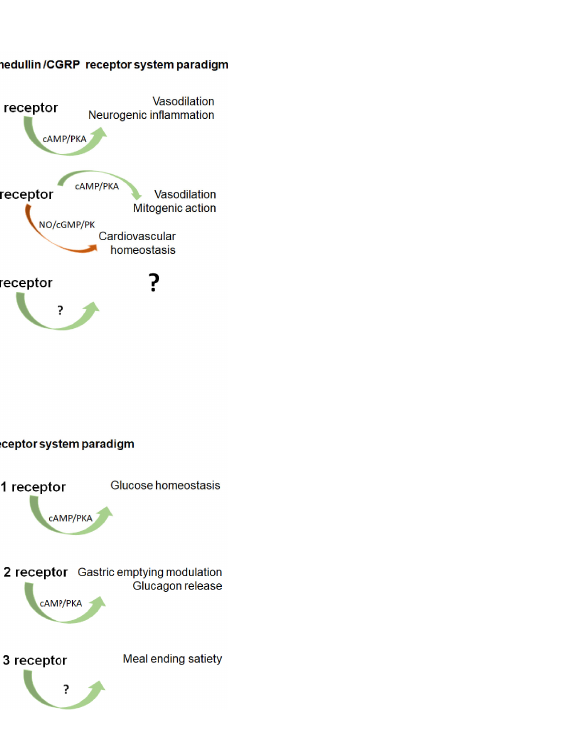
FIGURE 2 | Hypothetical schematic diagram of pluricellular eukaryote (mammalian) Calcitonin Receptor Like Receptor [CRLR (A) ] and Calcitonin Receptor [CTR (B) ]. The scheme illustrates CRLR and CTR association with RAMP-1 (red), RAMP-2 (yellow) and RAMP-3 (green) to conform the different G protein receptors subtypes and their functions. AM, adrenomedullin; AMY, amylin; cAMP, cyclic AMP; cGMP, cyclic GMP; CGRP, calcitonin gene related peptide; NO, nitric oxide; PK, protein kinase. With permission of Elsevier (Febres et al., 2018; Febres et al.,